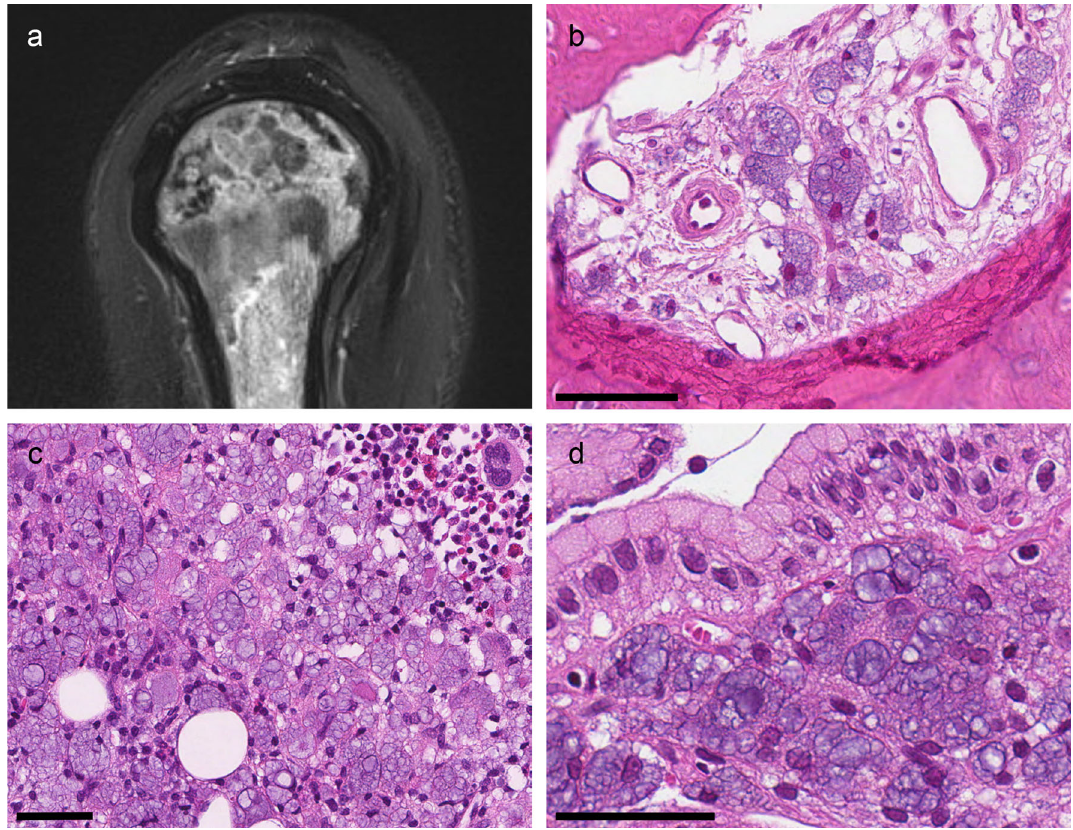
Figure 1. Radiological and biopsy findings. (a) MRI (T2-blade-sag-FS) of the right humerus showing mottled signal changes. (b) Clavicular bone (H&E): The marrow space is infiltrated by histiocytes with bluish transparent bubbles. (c) Bone marrow (H&E): Massive infiltration of histiocytes and scarce remaining hematopoietic tissue. (d) Gastric mucosa (H&E): Infiltration of vacuolated histiocytes in an extended lamina propria. All scale-bars 50 μ